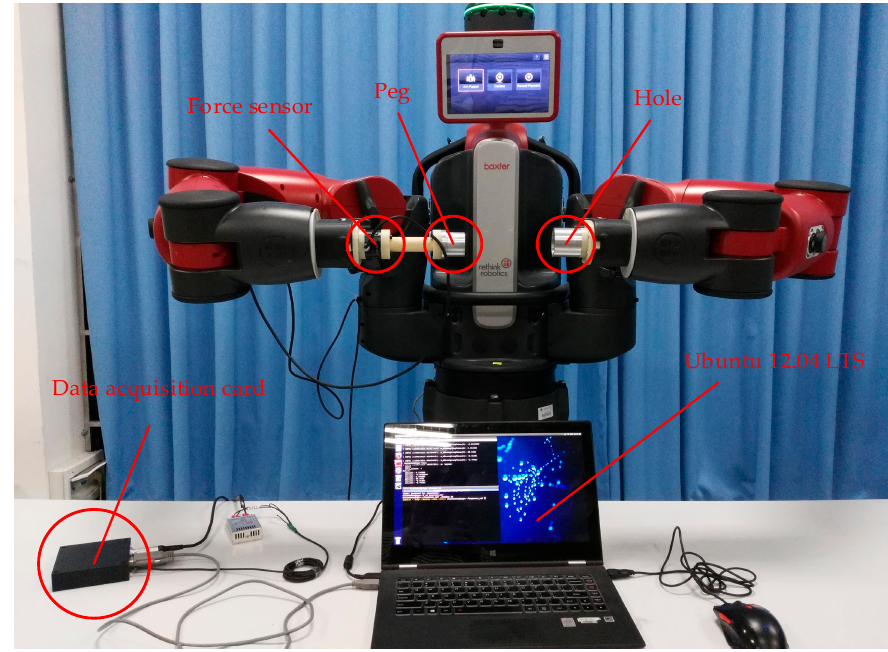
Figure 11. Experimental platform for a peg-in-hole assembly task.